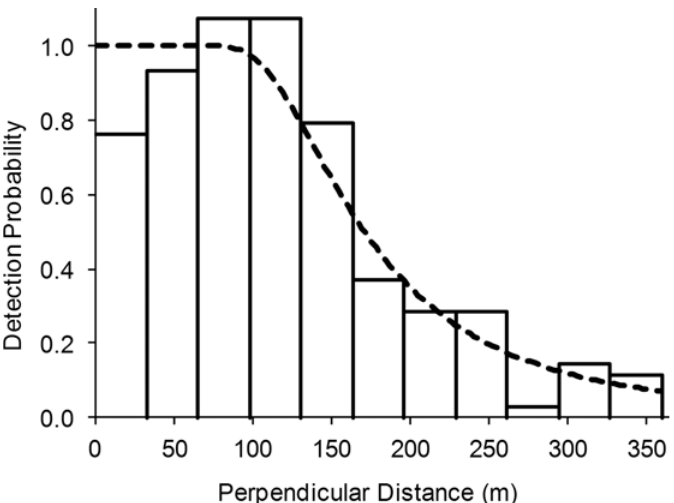
Fig 4. Plot of the detection function for sea turtles based on the AIC selected Conventional Distance Sampling (CDS) model. Histogram represents the probability of detection for each distance interval. The curved line is the detection function, showing the probability that a turtle is observed as a function of distance from the transect